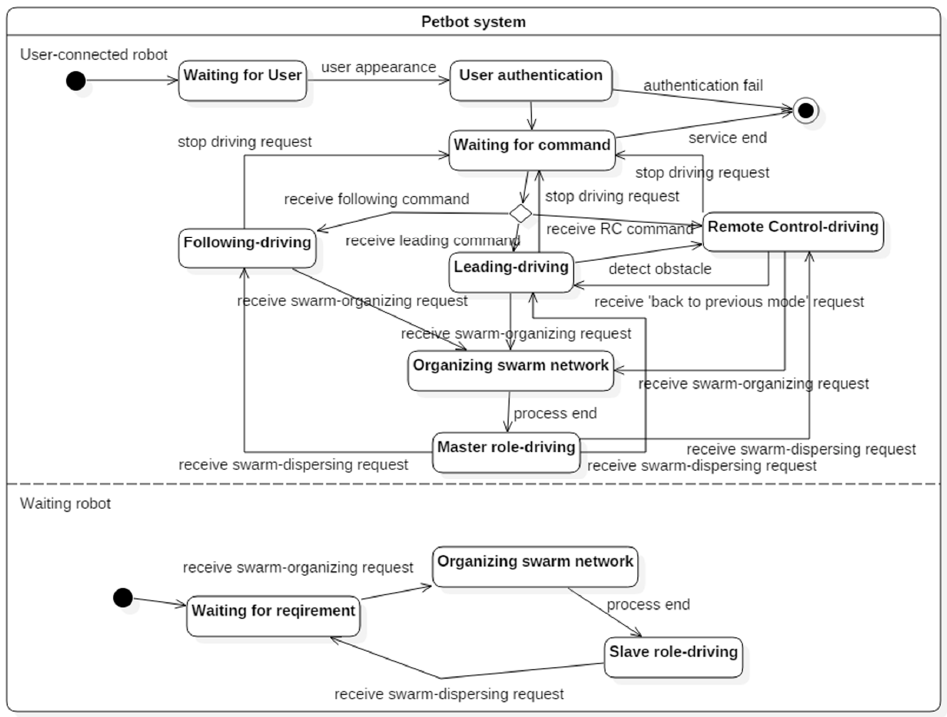
Figure 4. State diagram of the overall Pet-Bot system.